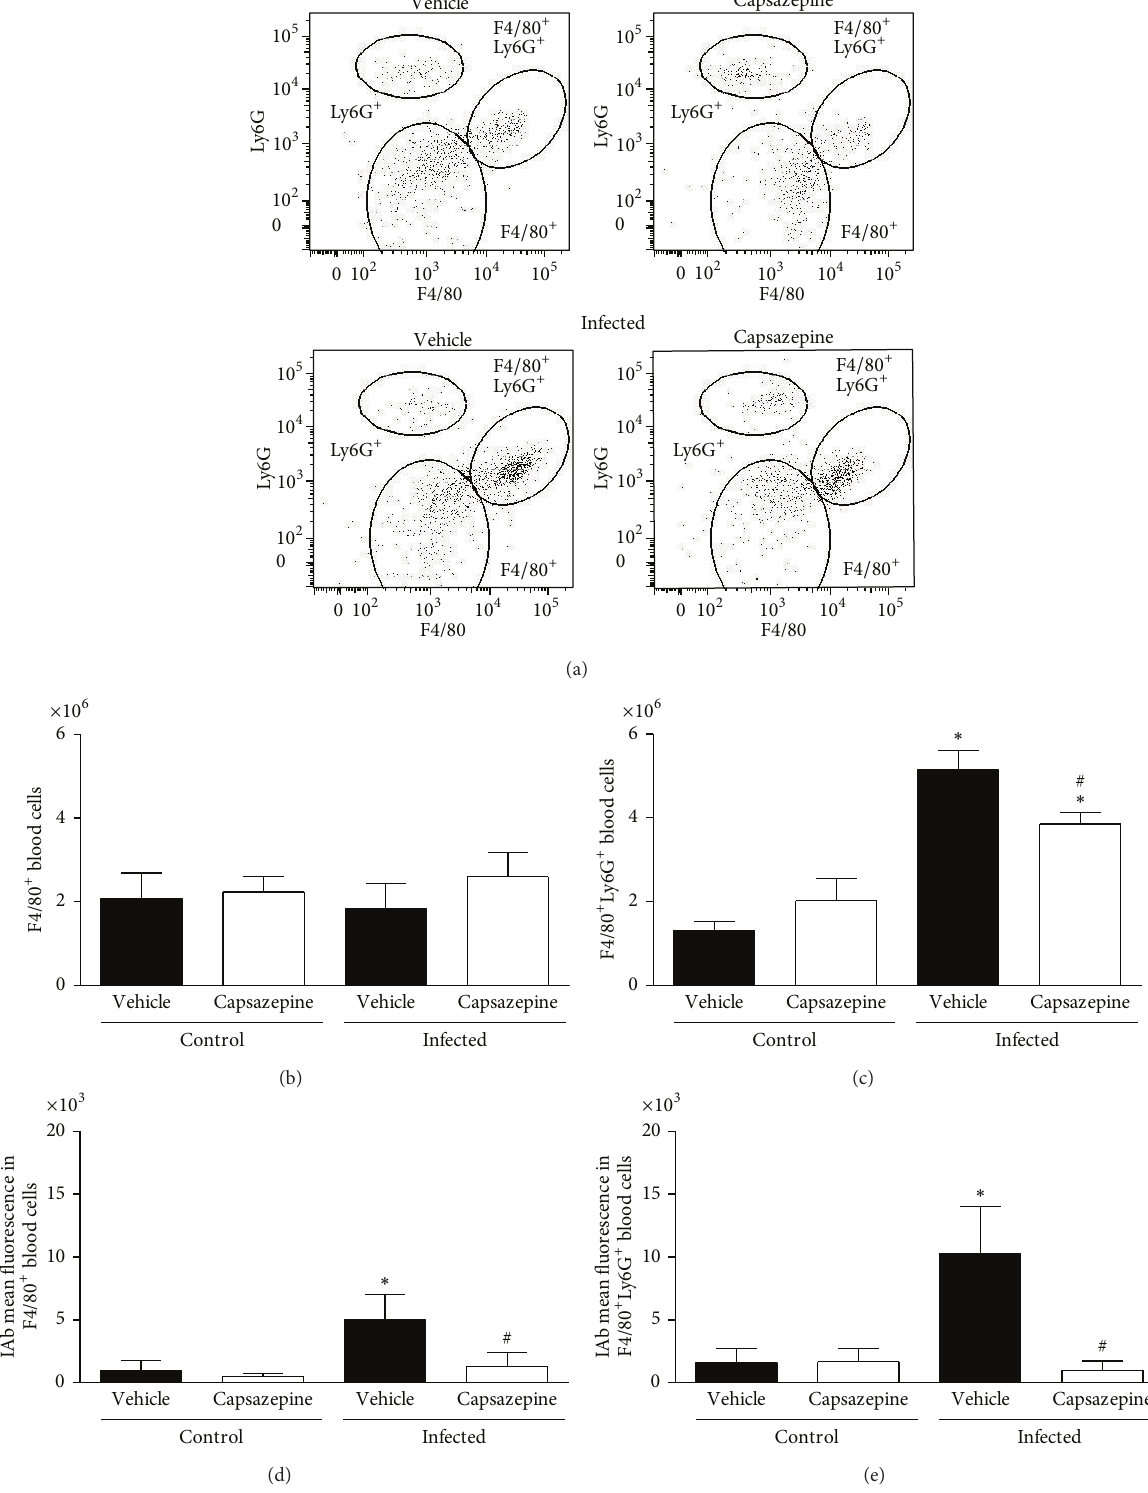
Figure 2: Effect of capsazepine on peripheral blood F4/80 + , F4/80 + Ly6G + , and Ly6G + cells. (a) Representative two-colour dot-plots for peripheral blood F4/80 + , F4/80 + Ly6G + , and Ly6G + cell populations from uninfected and Plasmodium berghei ANKA-infected mice (10 5 infected RBCs/animal; i.p.). Circulating (b) F4/80 + and (c) F4/80 + Ly6G + cell numbers in uninfected and Plasmodium berghei ANKA-infected mice (10 5 infected RBCs/animal; i.p.). Expression of IAb (mean fluorescence) on circulating (d) F4/80 + and (e) F4/80 + Ly6G + cell populations. Capsazepine (50 𝜇 g/animal, 2x day, for 6 days) was administered from 24 h infection. Vehicle- (10% DMSO in saline) treated animals were used as controls. Data are expressed as mean ± SD, 𝑛 = 5 per group. ∗ 𝑃 < 0.05 compared with respective uninfected (control) groups; # 𝑃 < 0.05 compared with vehicle-treated infected